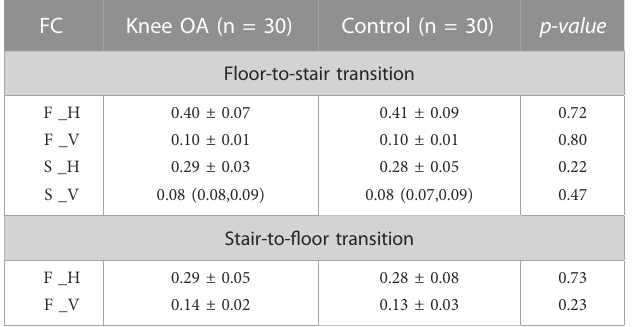
Joint angles at FC During fl oor-to-stair transition, when the leading leg approaches the edge of fi rst step, hip fl exion (57.15 ± 5.14 vs. 53.39 ± 7.20, p = 0.02) and internal rotation in the swing leg (4.37 ( − 0.52 ,7.55) vs. − 1.34